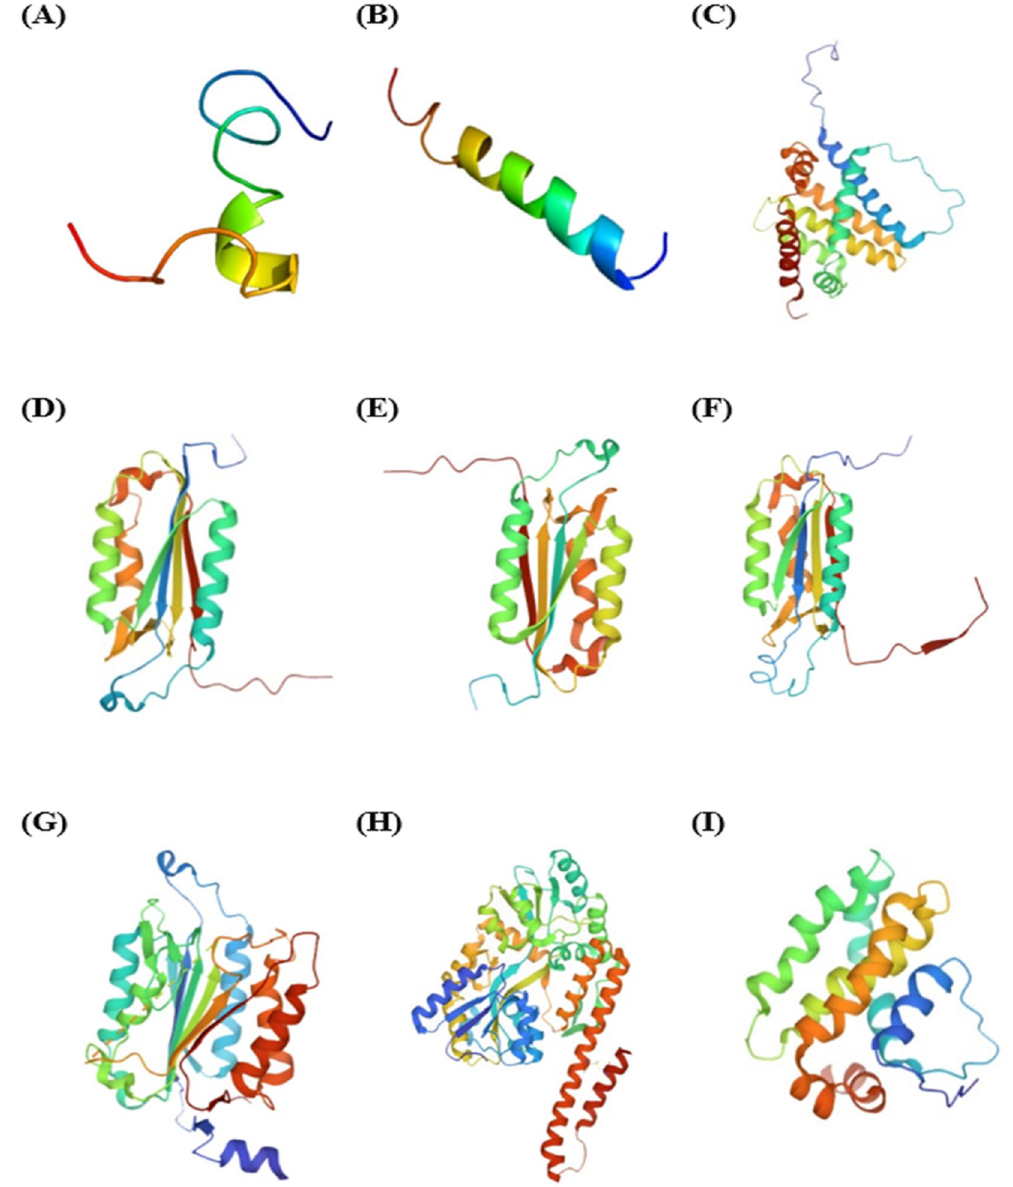
Figure 13. 3D model structure for peptides and proteins by using QuickDBD. ( A ) AtMP1, ( B ) AtMP2, ( C ) BAX, ( D ) caspase-3, ( E ) caspase-7, ( F ) caspace-8, ( G ) caspase-9, ( H ) p53, and ( I )